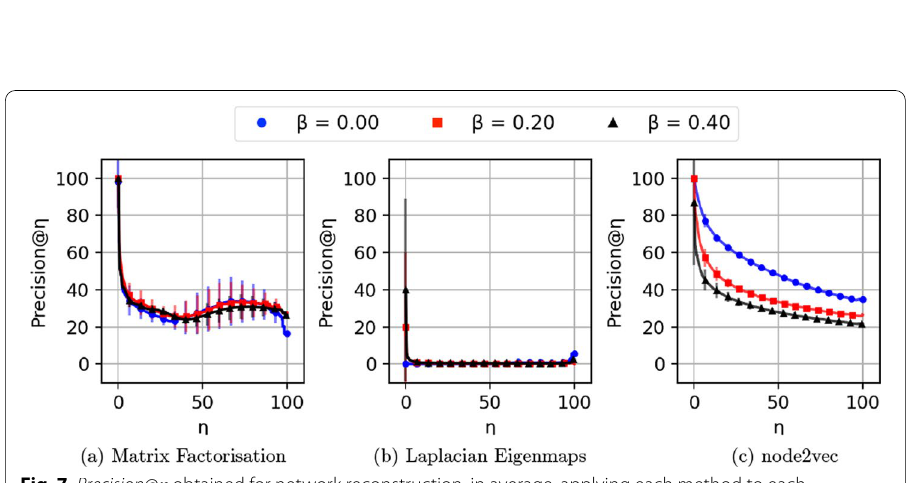
Fig. 7 Precision @ η obtained for network reconstruction, in average, applying each method to each generated data set ( γ = 2.25 ). η is expressed in